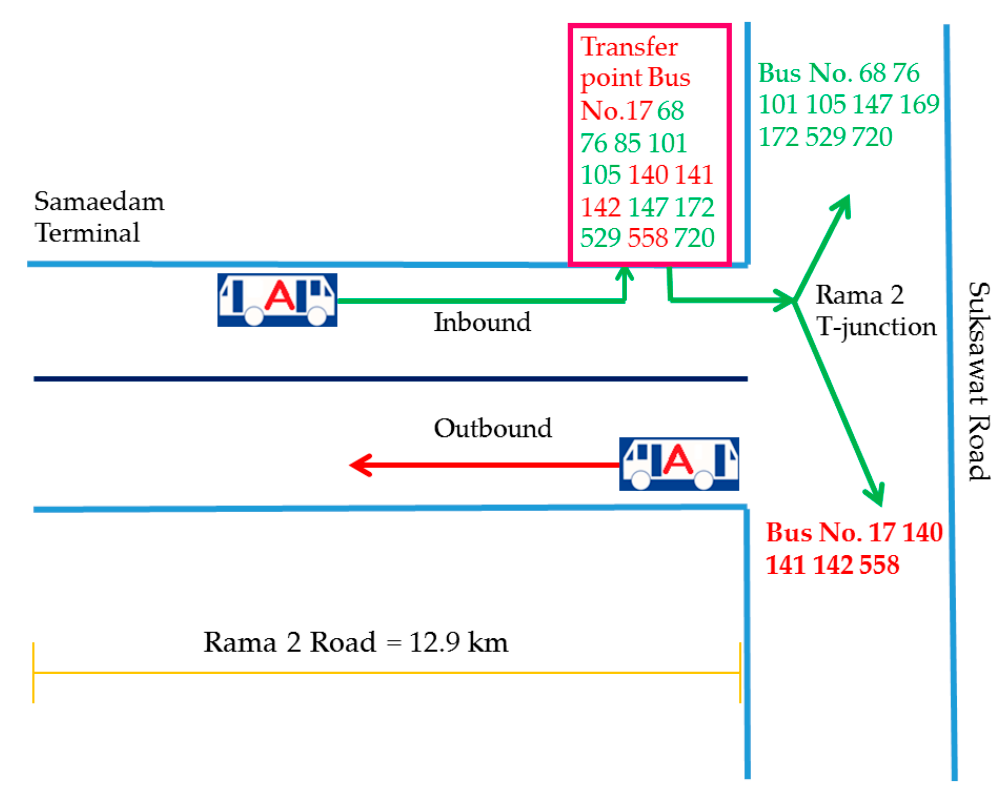
Figure 2. Bus Reform Using a Single Bus Line along the Overlapping Corridor (Rama 2 Road).